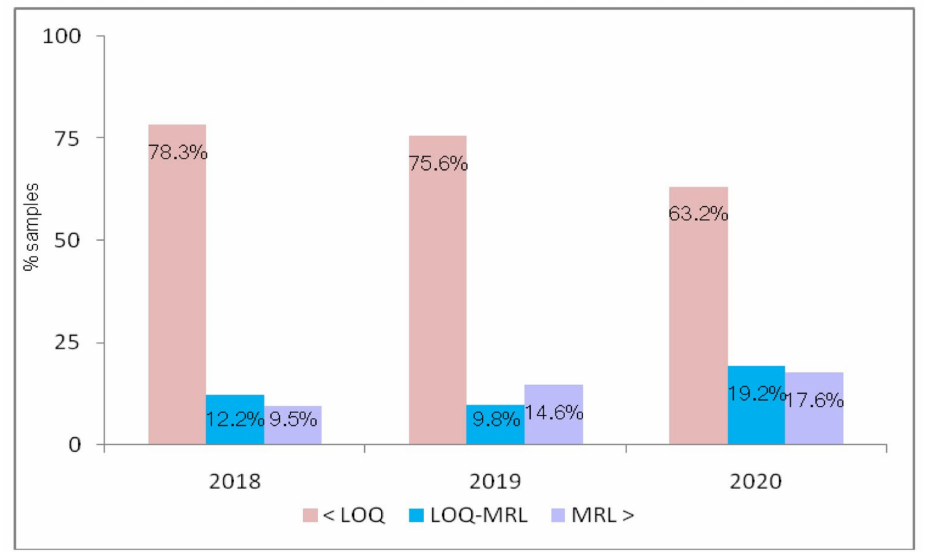
Figure 2. The distribution of fosetyl-Al content in cherry samples per harvest